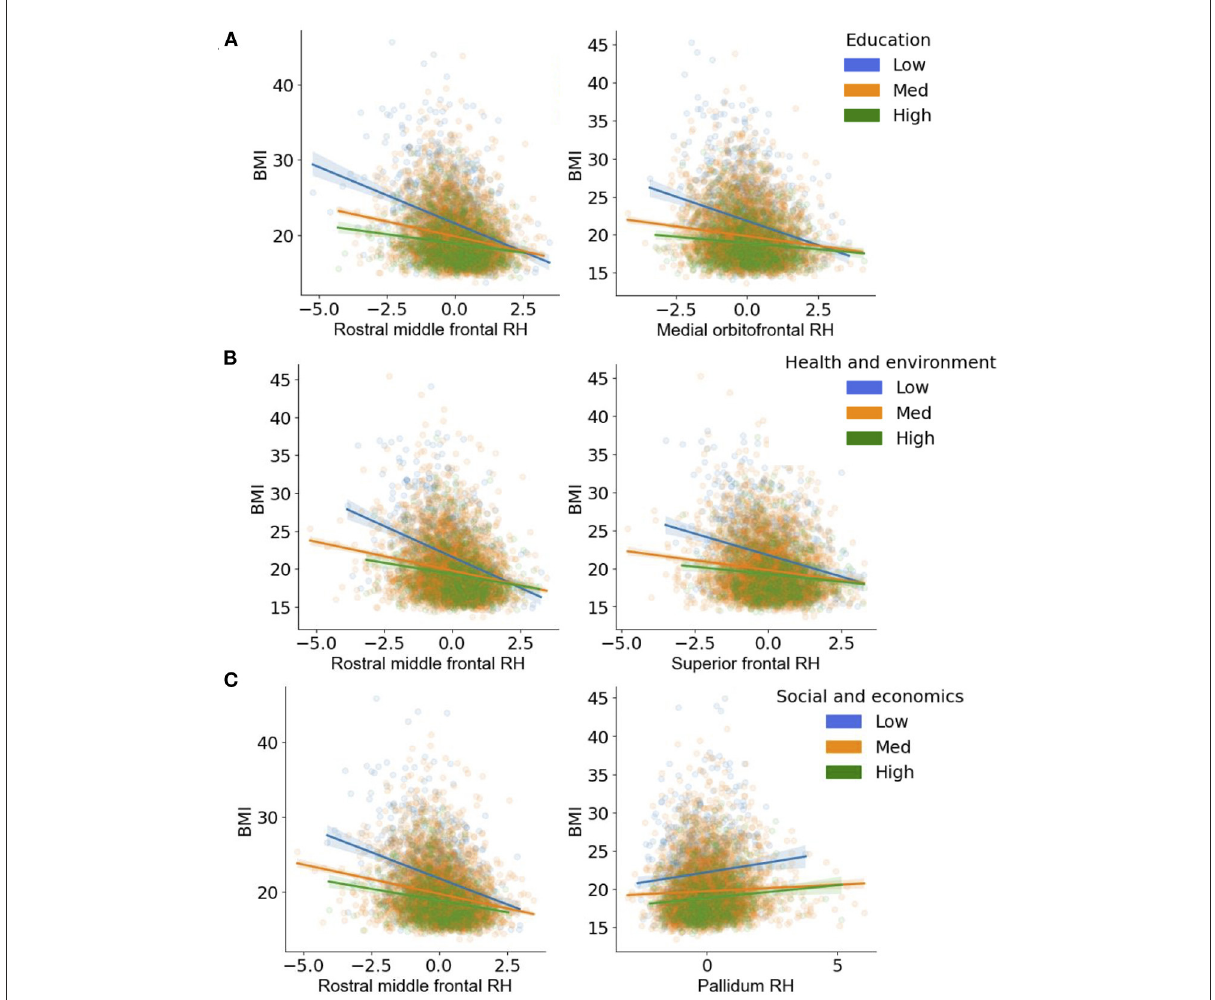
FIGURE5 (A–C) Visualization of the two-way interactions between the brain and each Child Opportunity Index (COI) domain of interest, while controlling for the other two COI domains of no interest, as well as income-to-needs, sex, puberty, race, ethnicity, and time (e.g., visit number [baseline, year-two follow-up]). The top two Brain * COI interactions are plotted for each domain. The y-axis presents the body mass index (BMI) predicted fits from the regression. (A) education [ED]; (B) health/environmental [HE]; (C) social/economics [SE]. Low (blue), medium (orange), and high (green) correspond to the values of each COI at − 1 standard deviation (SD) below the mean, at the mean, and 1 SD above the mean. Fit lines indicate the regression fit with a 95% confidence interval. Individual dots represent individual subjects collapsed over time. Lower values of each COI indicate that there were fewer resources in the area. RH,